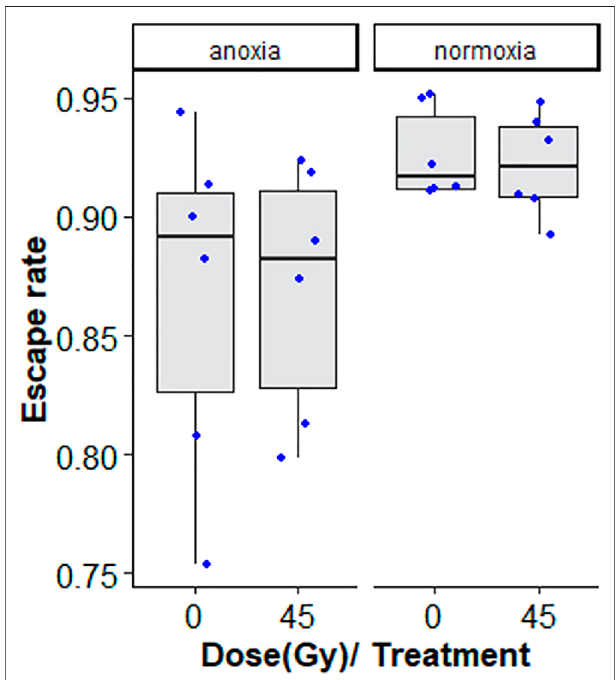
FIGURE 7 | Flight ability of adults treated in nitrogen [non-irradiated controls (N 2 C) and irradiated (N 2i )] compared to adults in air [non-irradiated controls (O 2 C) and irradiated in air (O 2i )]. The boxplot shows the median, and upperandlowerquartiles.Thedotsindicatethevaluesobtainedforeach repetition.